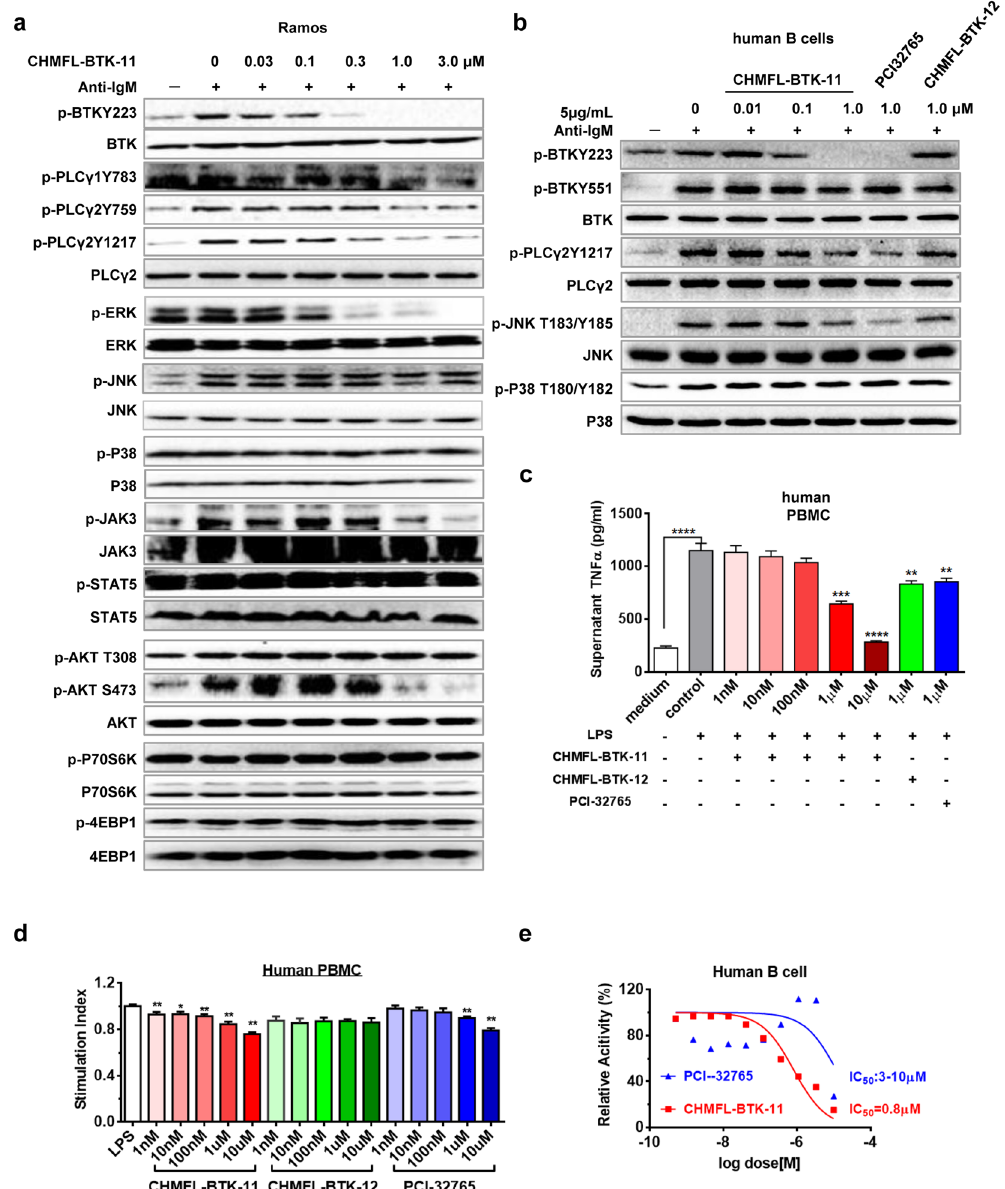
Figure 2. CHMFL-BTK-11 inhibits human B cell activation and proliferation. ( a ) The inhibitory effects of CHMFL-BTK-11 on BTK signaling in the Ramos cell line. Blots were cropped for improved clarity and conciseness. ( b ) The inhibitory effects of CHMFL-BTK-11 on BTK signaling in human B cells. Cells were stimulated with anti-IgM F(ab ′ ) 2 fragments in the presence of the indicated doses of CHMFL-BTK-11. Blots were cropped for improved clarity and conciseness. ( c ) CHMFL-BTK-11 inhibits TNF α production by human peripheral blood monocytes (PBMC) after LPS stimulation. ( d ) CHMFL-BTK-11 inhibits human PBMC proliferation after LPS stimulation. ( e ) The inhibitory effects of CHMFL-BTK-11 on proliferation of purified human B cells. PCI32765 was set as controls. Student’s t-test was used and data were representative of at least 2 independent experiments. * P < 0.05, ** P < 0.01, *** P < 0.001, and **** P < 0.0001. LPS,